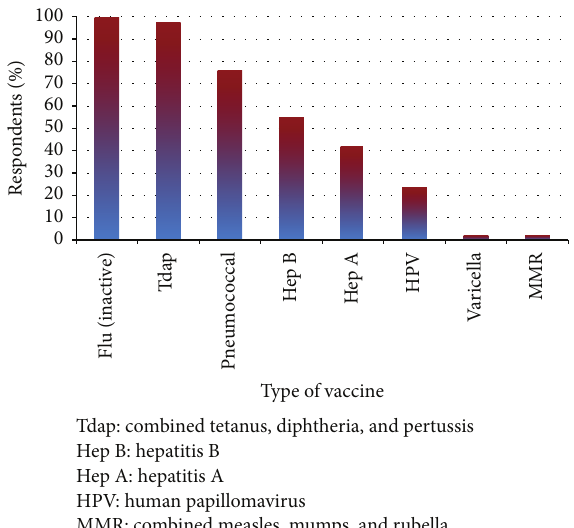
Figure 1: Responses to knowledge questions regarding safe vaccines in pregnancy.